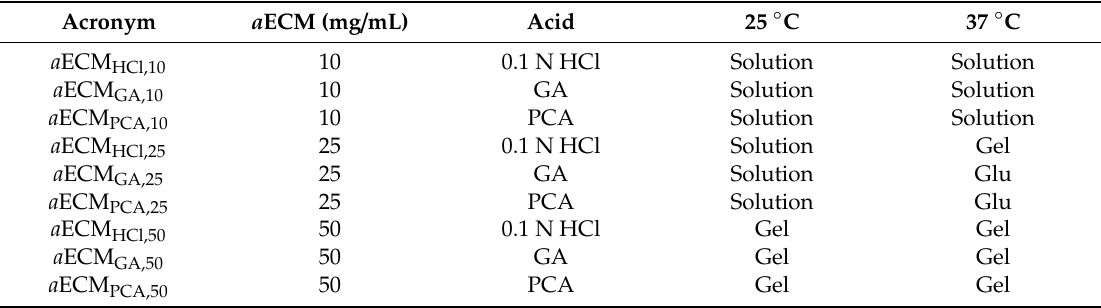
Table 1. E ff ects of di ff erent concentrations of acellular extracellular matrix ( a ECM) digested with pepsin in di ff erent acidic solution on the sol-gel status of hydrogels at 25 and 37 ◦